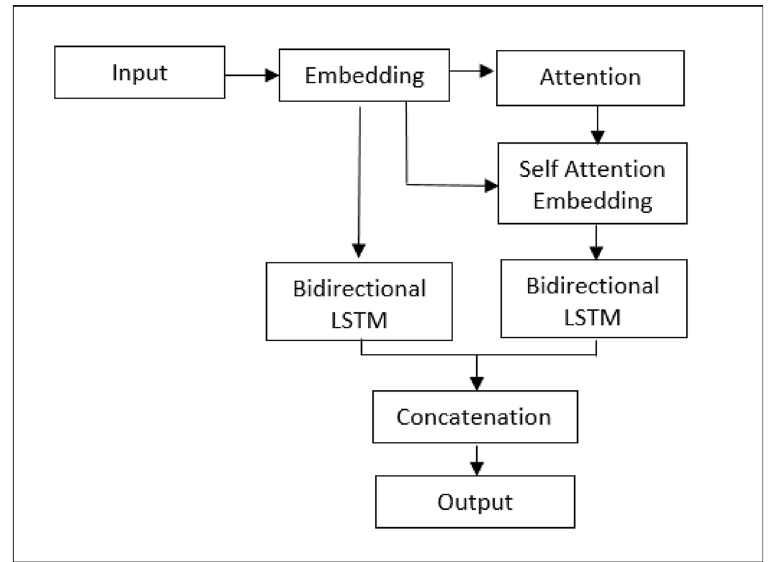
Figure 2. Structural design of